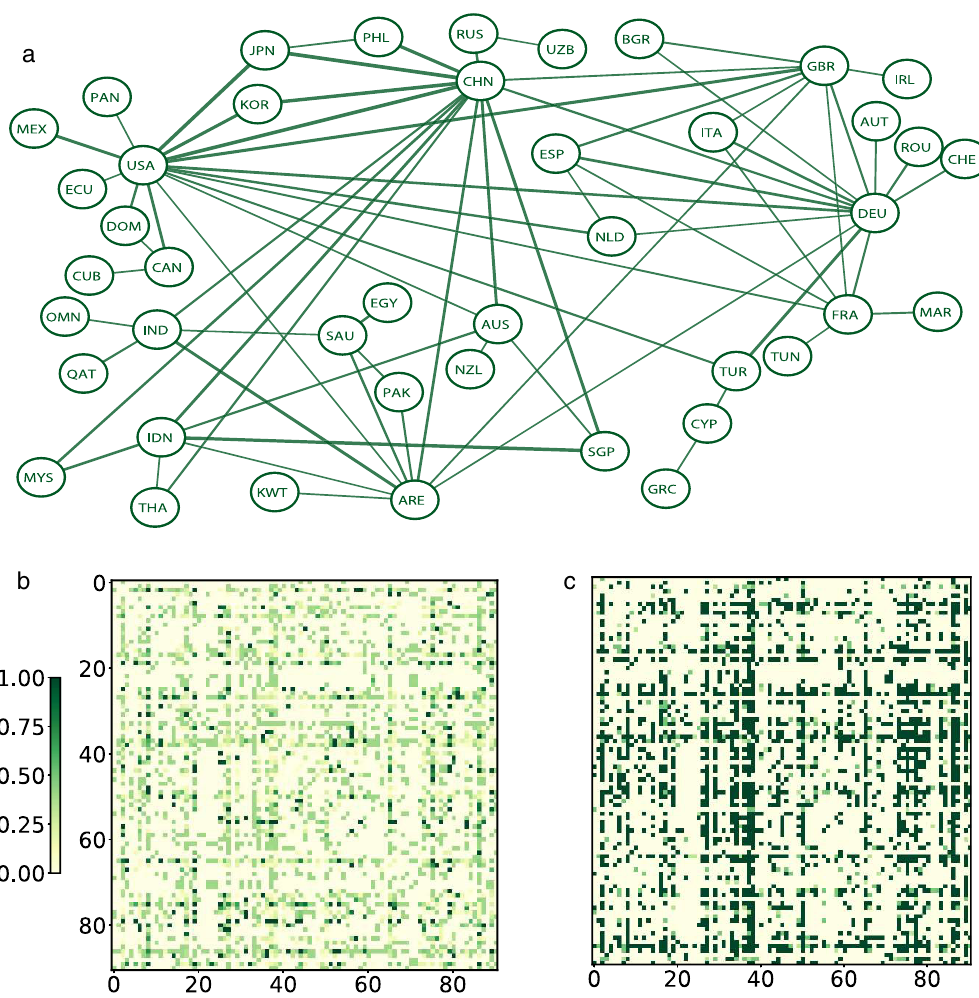
Figure 4. (a) Airline traffic network of countries in the top 5 % of mutual global airline travel volume in the first two weeks of June 2020. Each node corresponds to a country and thicker edges carry more travel. (b) Heat map of empirical travel volume in the first two weeks of June 2020 (compared to the first two weeks of June 2019), and (c) heat map of hypothetical travel volume in the first two weeks of June 2020 under our proposed policy (compared to the first two weeks of June